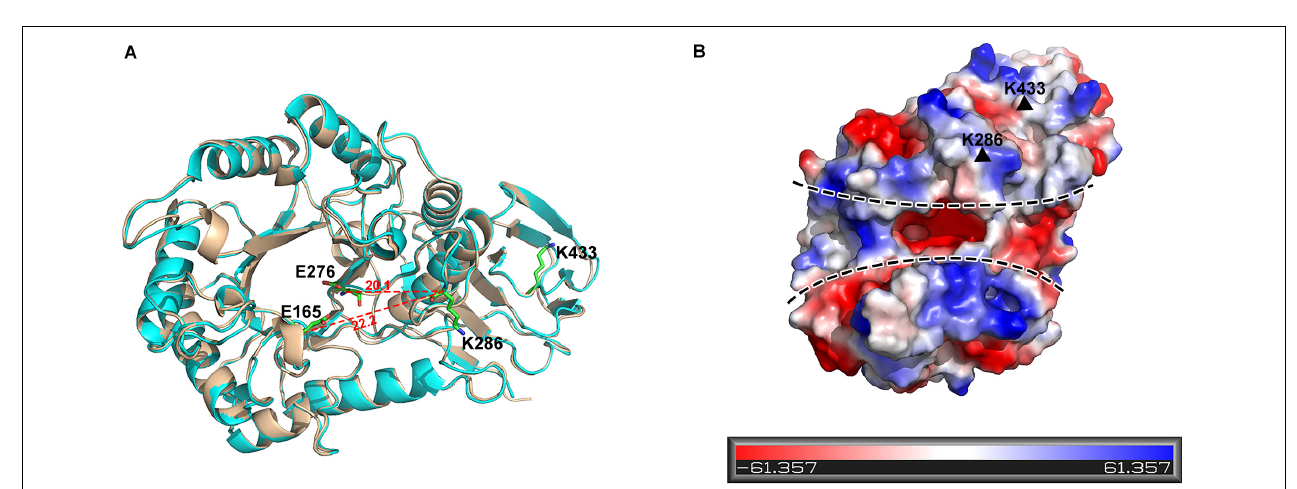
FIGURE 5 | K286 and K433 are spatially far away from the active sites, and their mutants do not affect structure folding. (A) Structural alignment of wild-type PslG and PslG K 286 A / K 433 S . The crystal structure of PslG is shown in wheat. The structure of PslG K 286 A / K 433 S was obtained through homologous modeling using ITASSER, and is shown in cyan. The key catalytic residues (E165 and E276) and trypsin hydrolysis sites (K286 and K433) are shown as sticks. (B) Electrostatic potential of PslG with negatively and positively charged regions colored in red and blue, respectively. The substrate-binding groove is marked by dashed lines, and residues K286 and K433 are marked by black